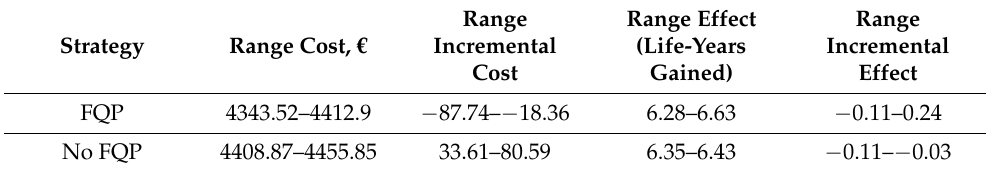
Table 3. Range of results of the one-way sensitivity